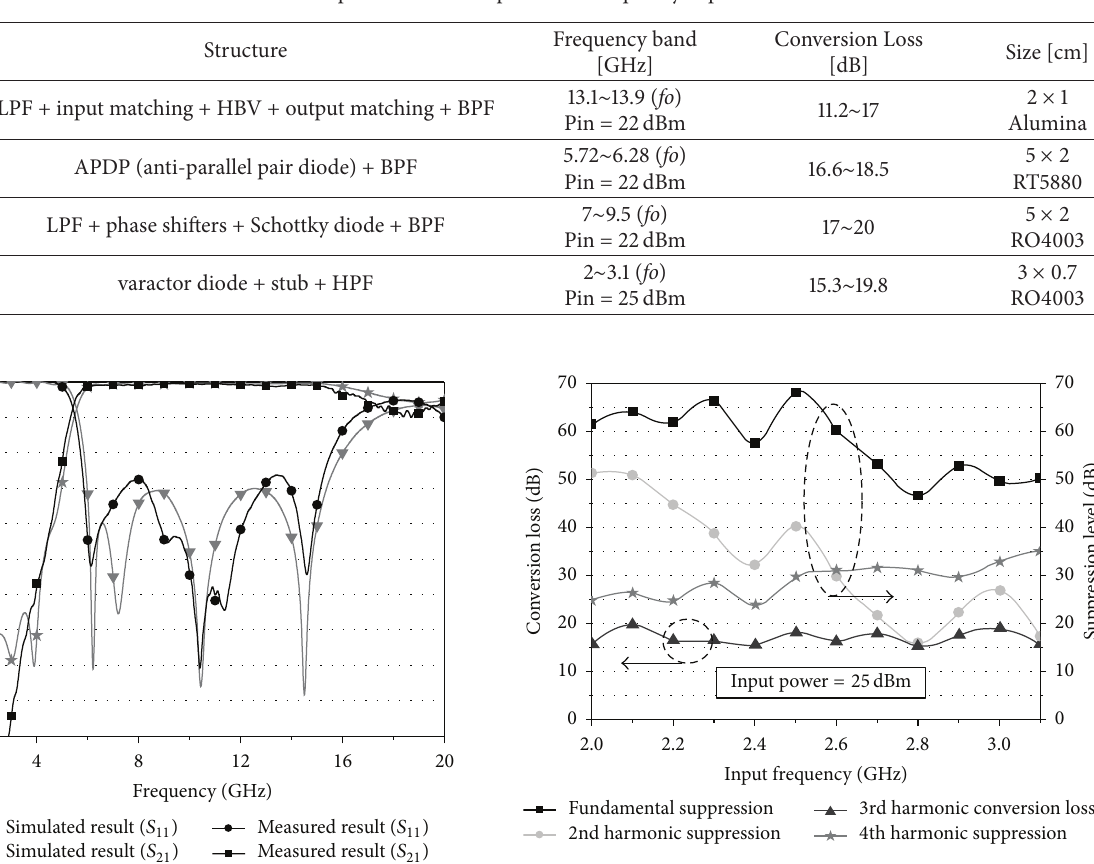
Figure9:Thirdharmonicconversionlossandthesuppressionlevels of the fundamental, 2nd, and 4th harmonics with +25dBm of input